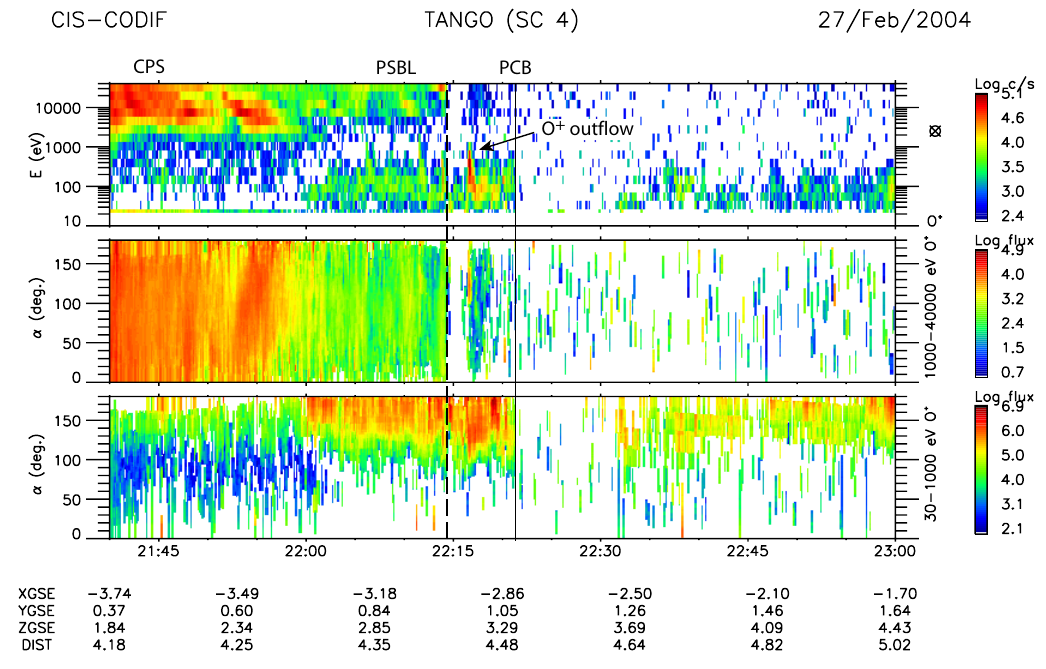
Fig. 8. Same as Fig. 7, but for s/c C4.